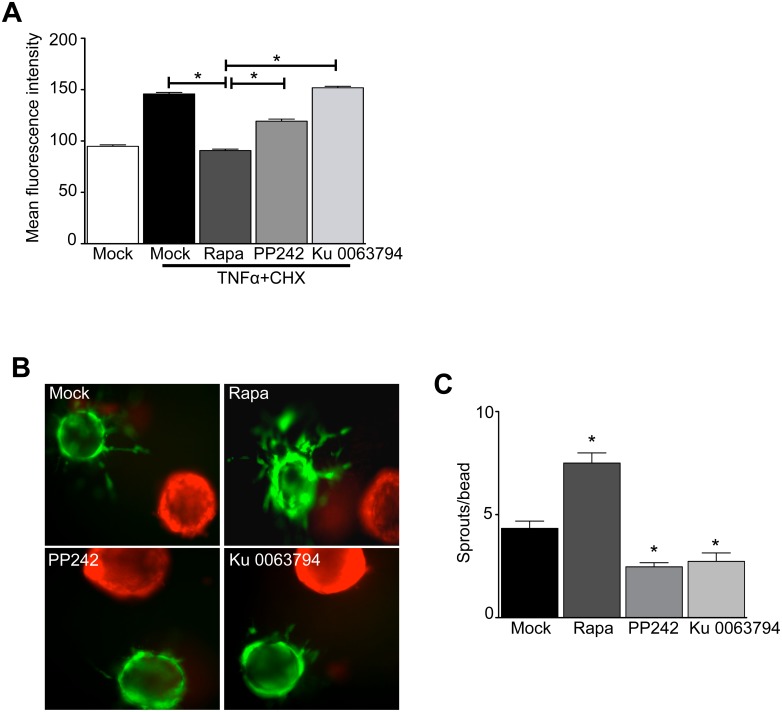
mTORC1 inhibition primes endothelial cells to resist apoptosis and to respond to tumour-derived pro-angiogenic cues.HUVECs were treated with Rapamycin (5 nM), PP242 (1 uM), or Ku 0063794 (50 nM) for 24 hours. A) The EC were challenged with tumor necrosis factor-α (TNFα) + cycloheximide (CHX) for 4 hours in normal growth conditions. Active cleaved caspase-3 was detected by DEVD-FMK-FITC and analyzed by flow cytometry as described in Methods. Quantitation of active caspase-3 in mock-, rapamycin-, PP242-, and Ku 0063794-treated ECs (n = 4 independent experiments, *P<0.05 by ANOVA). B) Evaluation of EC angiogenic sprouting to tumor-derived growth factors in vitro. HUVEC were pretreated with Rapamycin (5 nM), PP242 (1 uM), or Ku 0063794 (50 nM) for 24 hours, then mounted on Cytodex beads (green) and were embedded with renal cell carcinoma cell-coated beads (red) in 3D fibrin gels as described in Methods, then co-cultured without additional growth factor supplementation or inhibitors. Representative images of EC sprouts after 18 hours incubation. C) Quantitation of the number of sprouts per bead (n = 3 independent experiments, *P<0.05 by ANOVA).